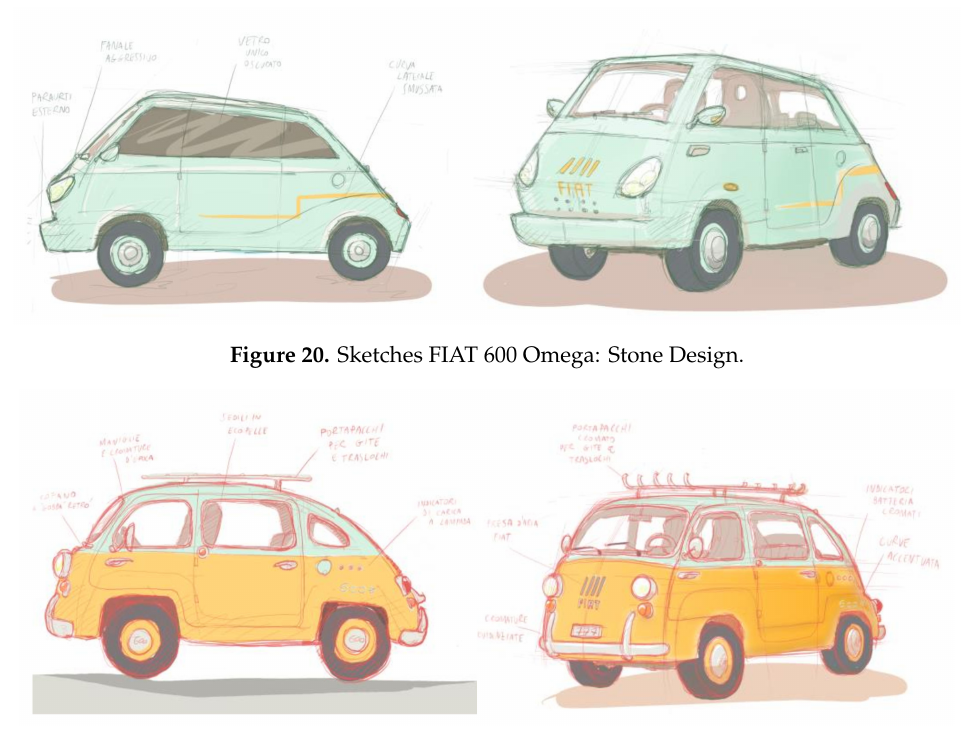
Figure 21. Sketches FIAT 600 Omega: Retr ò Design.